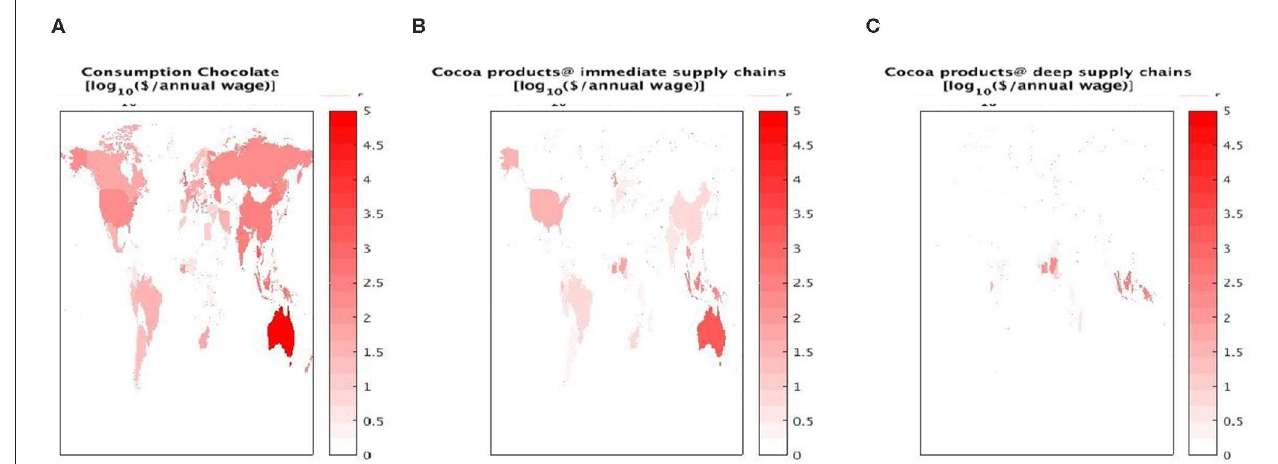
FIGURE 6 | Chocolate consumption and outputs of cocoa products. Consumption of chocolate in Australia (A) , and output of cocoa products in the first five supply-chain layers upstream from chocolate (B) , and in the remaining upstream supply chains (C) .